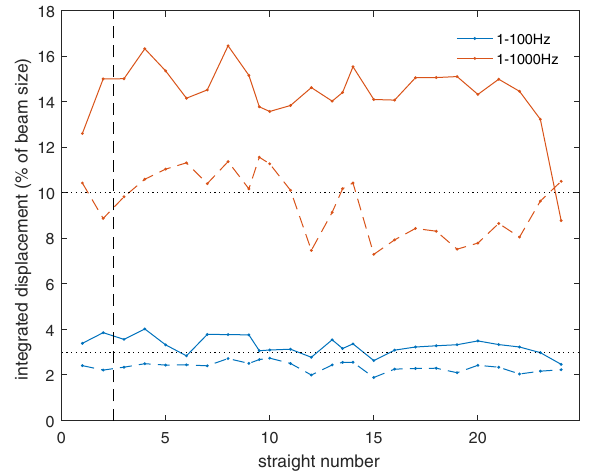
FIG. 14. Vertical orbit motion in the straight sections as a percentage of beam size. Data recorded before (dashed colored lines) and after (solid colored lines) the installation of the DDBA cell (vertical dashed black line) are shown. Fast orbit feedback was running during the